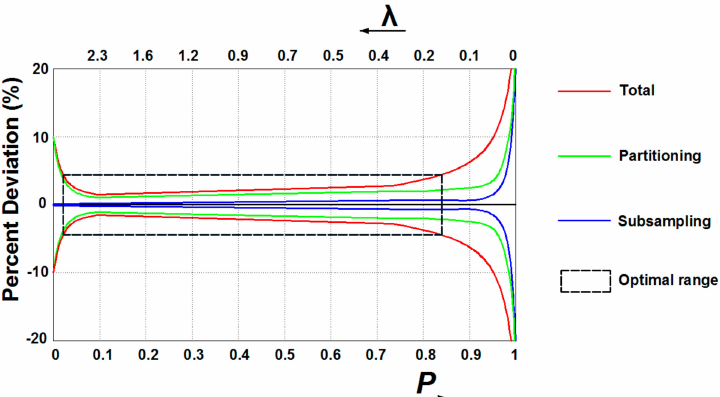
Figure 4. Schemes of assumed total, partitioning, and subsampling errors in digital PCR